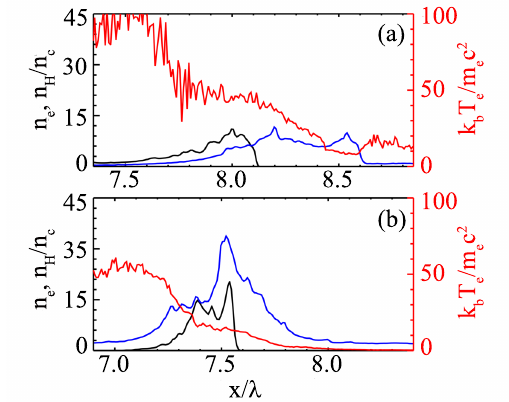
Figure 3. Plasma temperature (red line) averaged over | y | ≤ 2 λ at t = 18 T 0 for the cases ( a ) without and ( b ) with the NCD plasma, respectively. In each plot, the black and blue lines indicate the densities of the protons n H and electrons n e averaged over | y | ≤ 2 λ